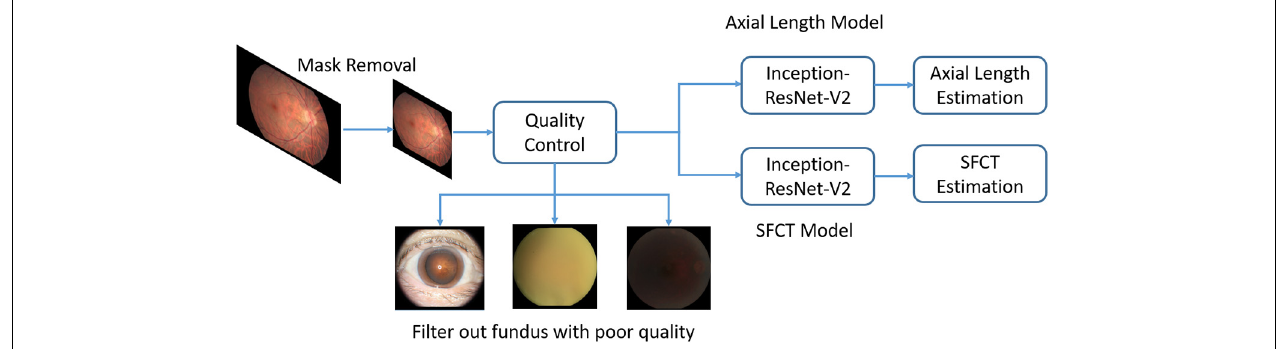
FIGURE 2 | Overview of a deep convolutional neural network (CNN)-based model training pipeline to automatically estimate axial length and subfoveal choroidal thickness from color fundus